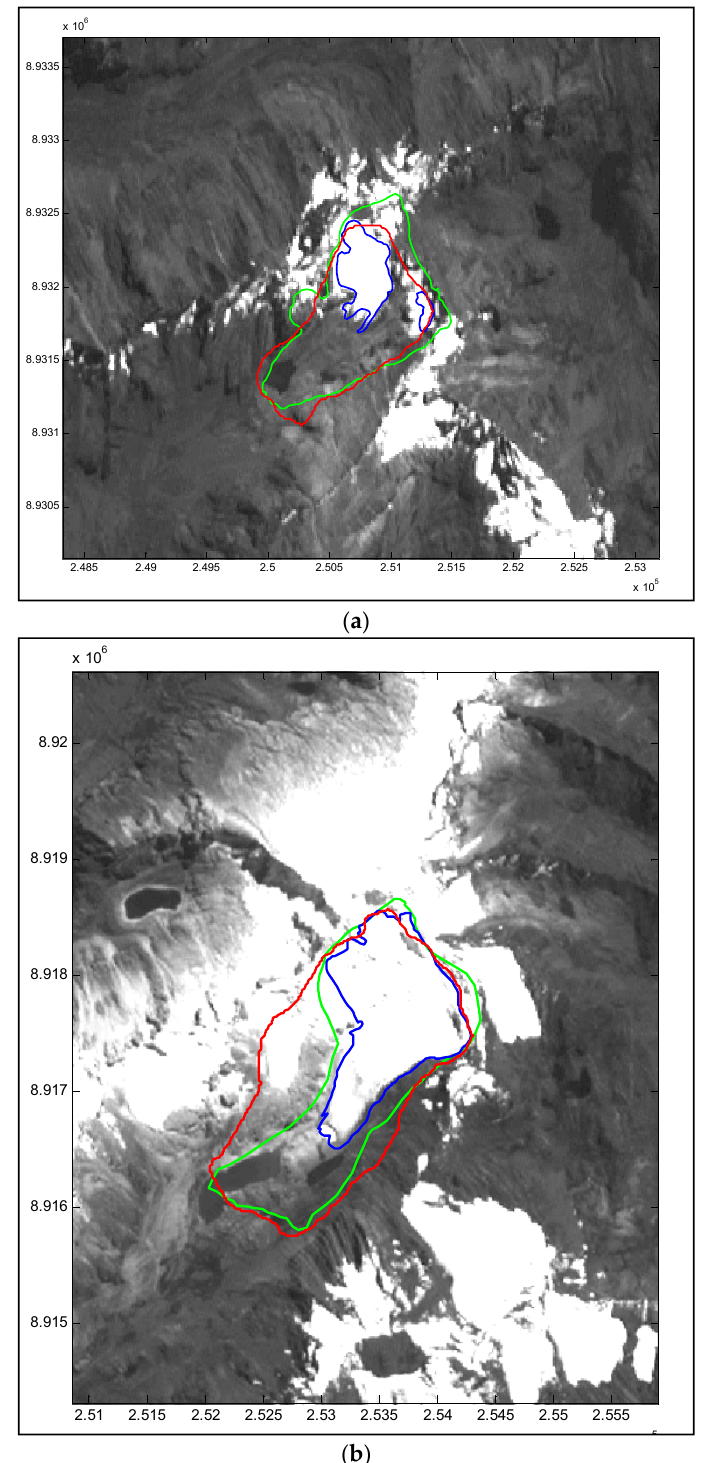
Figure 5. The test run result of 1962 from the cellular automata model for both YAN ( a ) and QUE ( b ). The results of the 1962 model run (red; 49-year time simulation) agree with the boundary drawn from the 1962 aerial photos (green). The polygon of the 2008 boundary is shown in blue.